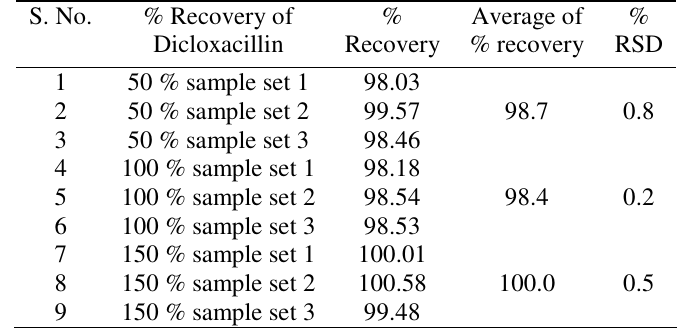
Table 3. Accuracy of the method for determination of amiciline and dicloxacillin capsule dosage